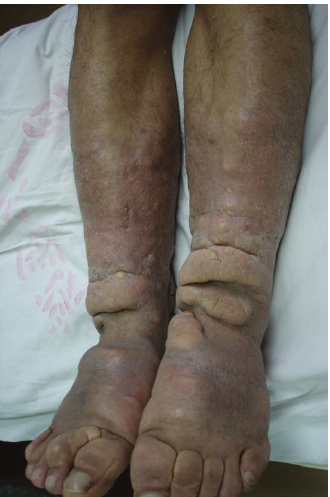
Figure 9: Sclerotic stage. Pigmented, woody hard lesions of ele- phantiasis without any active